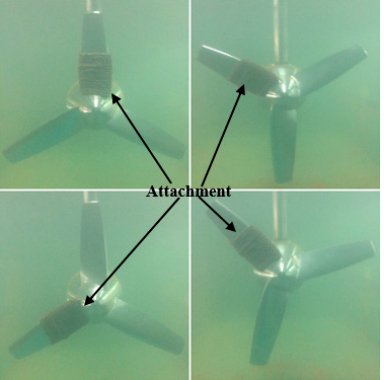
Figure 5. Four configurations of blade data acquisition.